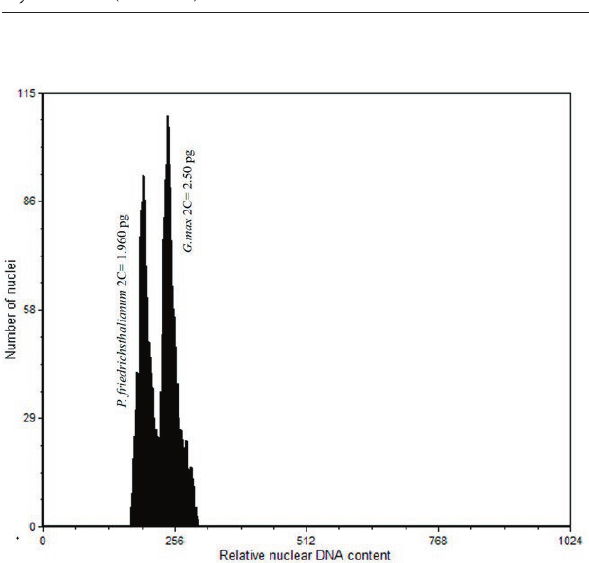
Figure 3. Relative fluorescence intensity (propidium iodide (PI)) histogram obtained after a simultaneous cytometric analysis of nuclei of reference standard ( Glycine max, 2C=2.50 pg of DNA) and Psidium friedrichsthalianum (2C= 1.960 ± 0.005